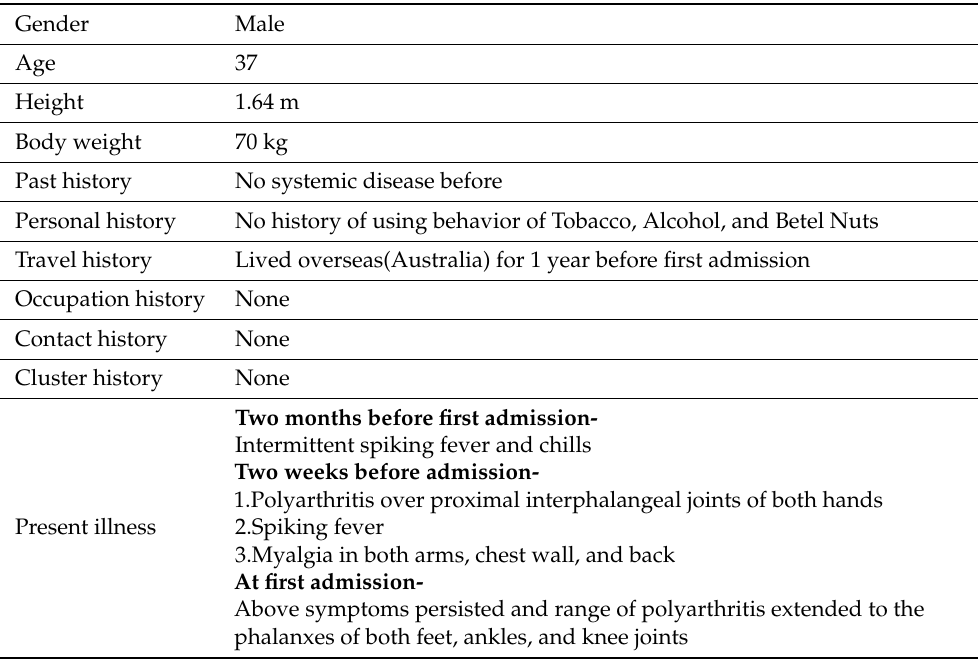
Table 1. Health summary of patient before first